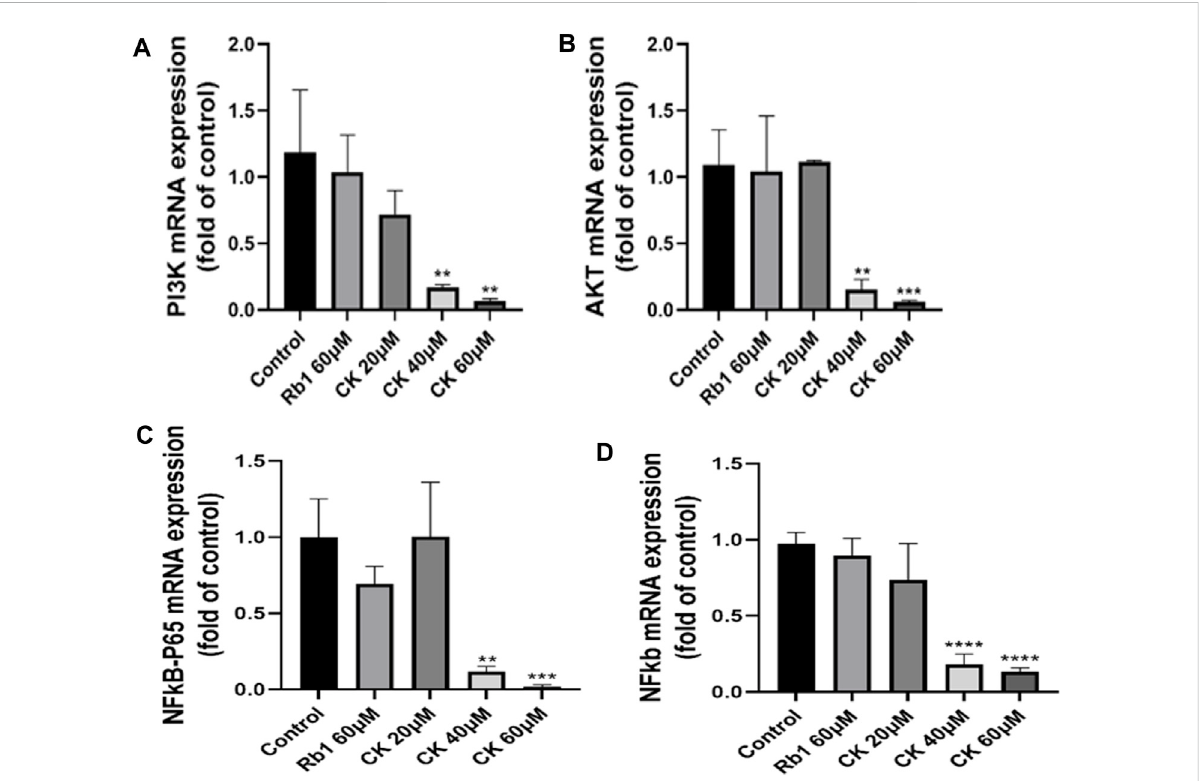
FIGURE 7 EffectsofGinsenosideRb1andGinsenosideCKonapoptosis-related pathwaysmRNAinHGC-27 (A) Histogramscomparingtheexpressionsof PI3K mRNA in apoptosis-related pathways. (B) Histograms comparing the expressions of AKT mRNA in apoptosis-related pathways. (C) Histograms comparing the expressions of NF- κ B p65 mRNA in apoptosis-related pathways. (D) Histograms comparing the expressions of NF- κ B mRNA in apoptosis-related